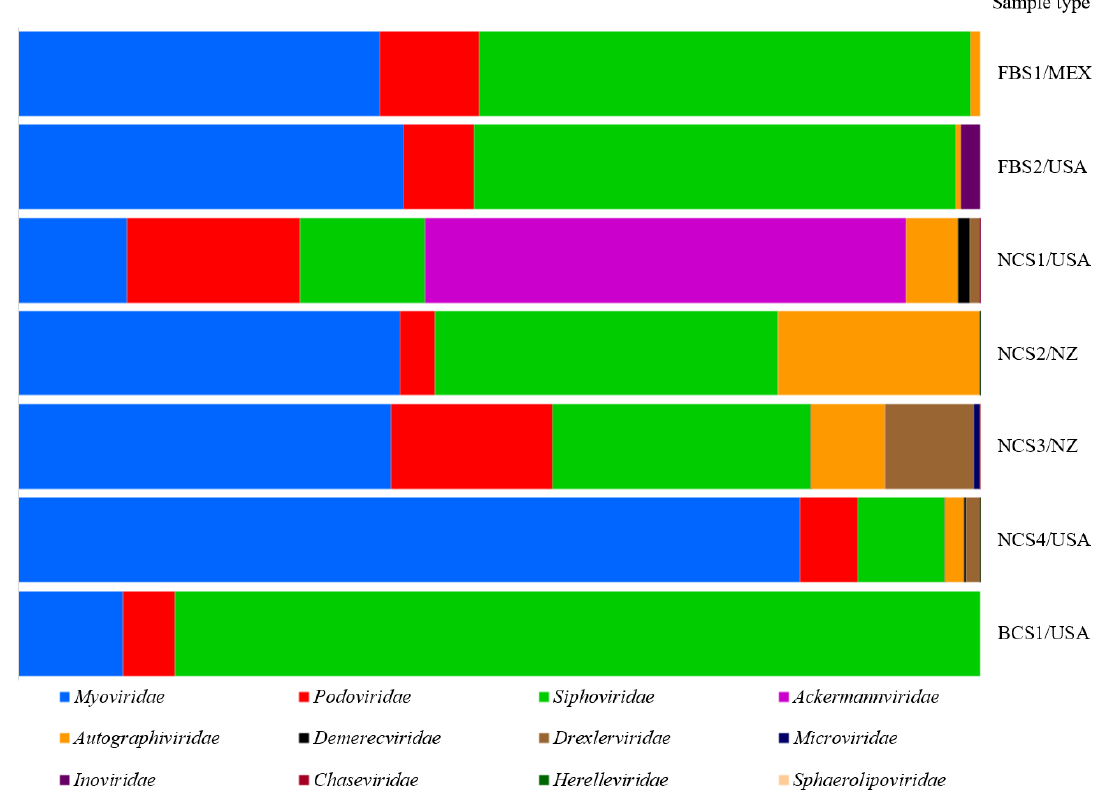
Figure 3. Taxonomic classification of bacteriophage reads. Bar chart representation of the reads based on BLASTN, E -value < 1 × 10 − 5 against the GenBank non-redundant database. Sample type: fetal bovine serum (FBS), newborn calf serum (NCS), and bovine calf serum (BCS). Serum origin: Mexico (Mex), New Zealand (NZ), and the United States of America